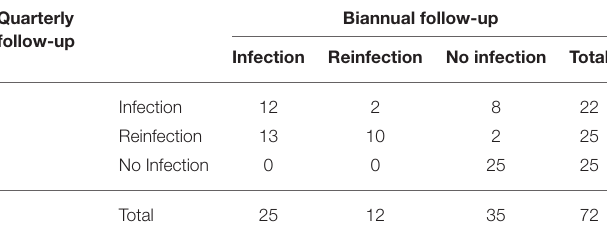
TABLE 2 | Concordance between the biannual and quarterly follow-up